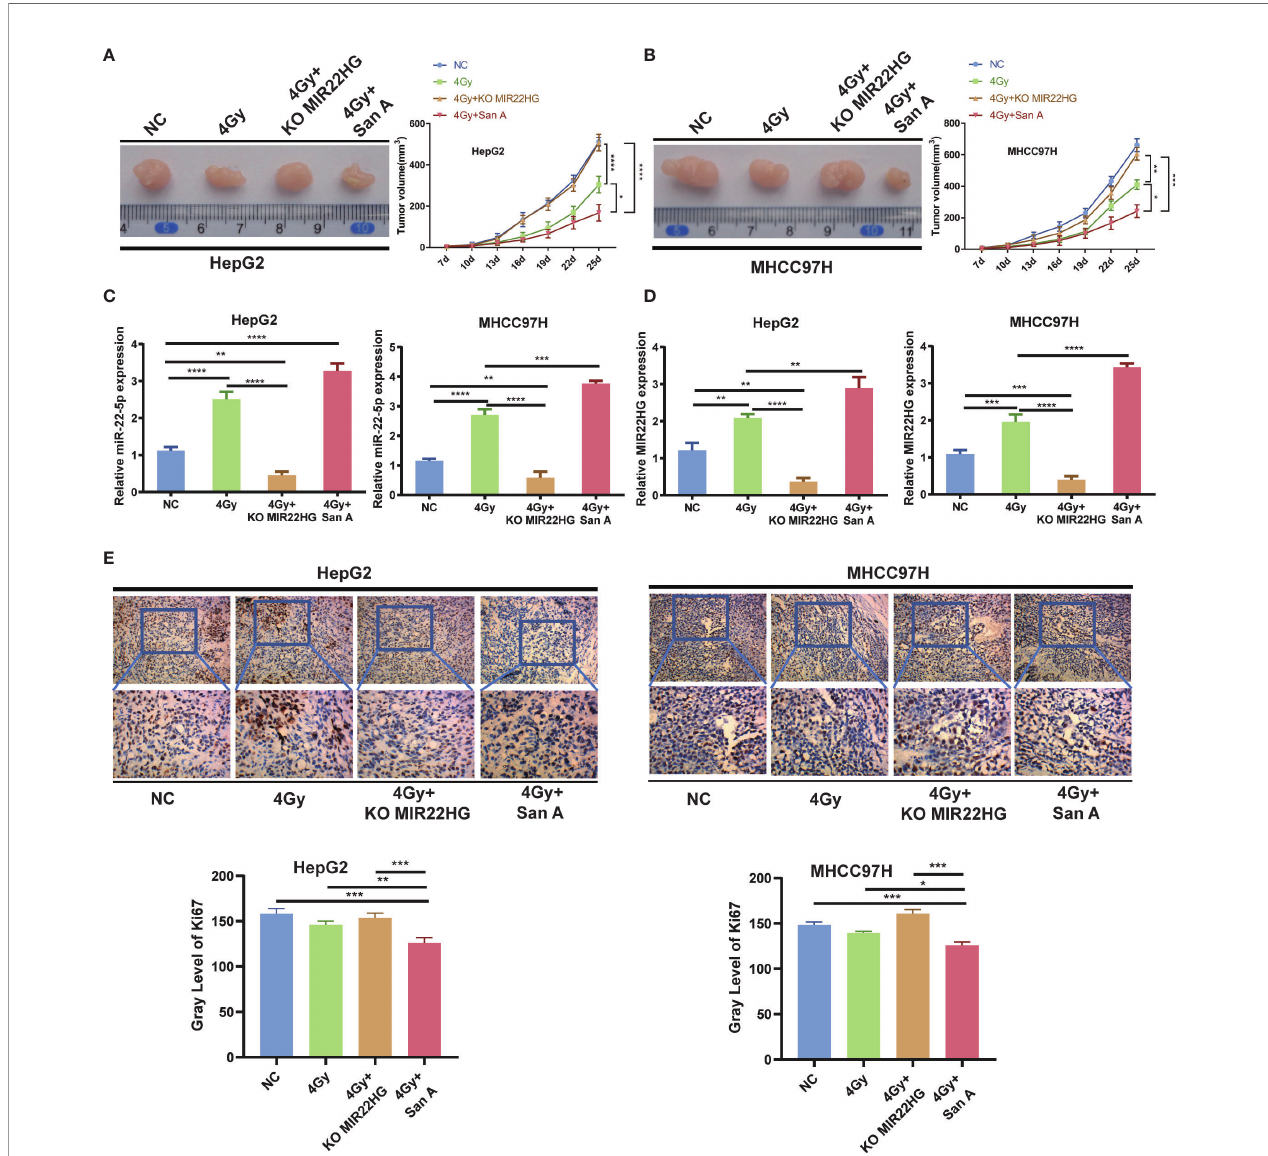
FIGURE 5 | (A, B) Tumor tissues isolated from the indicated mice on day 25 post-transplant. Tumor growth curve in nude mice. After tumor cells were injected subcutaneously into the right fl ank of the abdomen of the nude mice, the short and long diameters of the tumors were measured every 3 days and tumor volumes (mm 3 ) were calculated. (C, D) qPCR of MIR22HG and miR-22-5p mRNA expression in HepG2 and MHCC97H xenografts. (E) Immunohistochemistry showing the Ki67 expression of HepG2 and MHCC97H xenografts. Mean ± SD (n = 3 independent experiments). * p < 0.05, ** p < 0.01, *** p < 0.001, **** p <